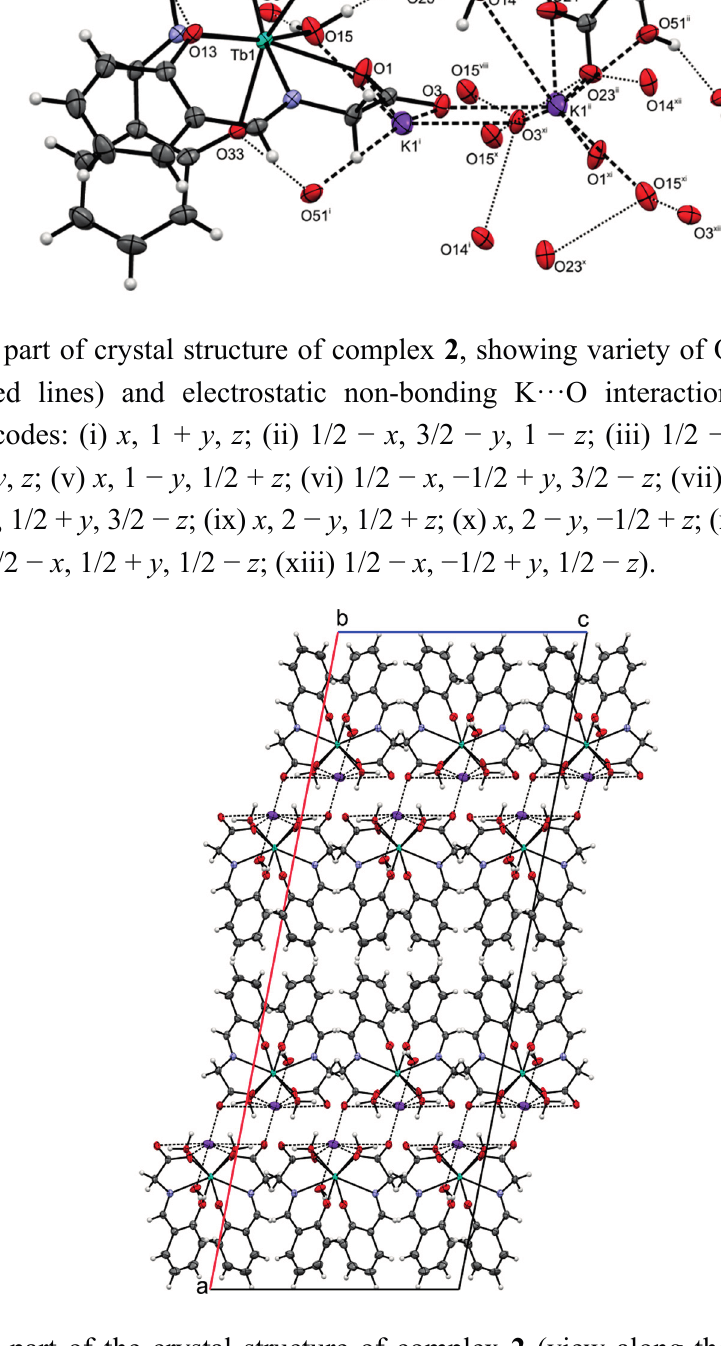
Figure 3. A part of the crystal structure of complex 2 (view along the b -axis), showing formation of 2D supramolecular